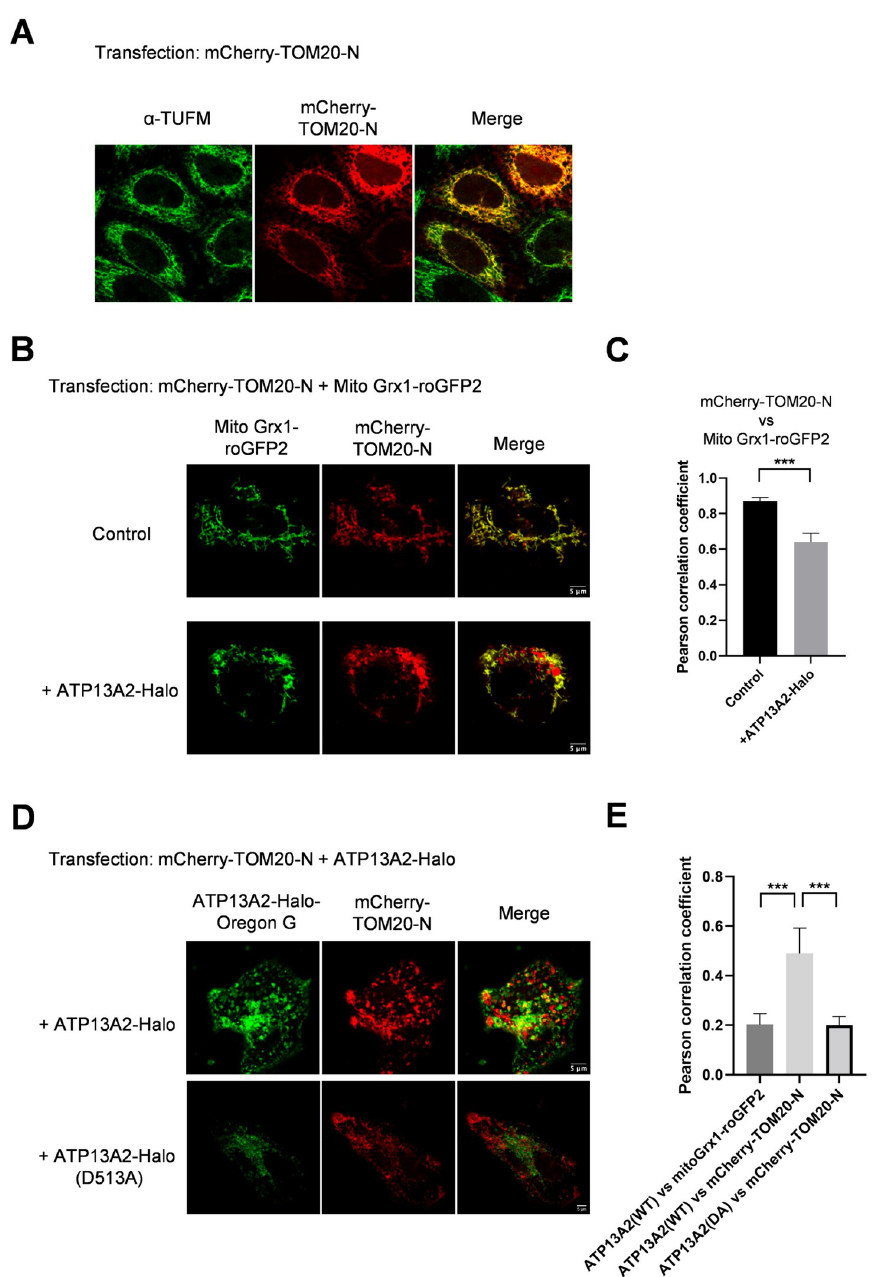
Fig 3. ATP13A2 overexpression altered the intracellular distribution of mCherry-TOM20-N (mitochondrial outermembrane, MOM). (A) MOM protein, mCherry-TOM20-N, was overexpressed in HeLa cells and mitochondrial localization was confirmed by immunostaining; TOM20 exhibited complete colocalization with the endogenous mitochondrial protein, TUFM. (B) Mitochondria was visualized by mitochondrial intermembrane space (IMS)/matrix marker, mito Grx1-roGFP2. Upon co-overexpression of ATP13A2, substantial portion of mCherry- TOM20-N appeared as particulate structures. Scatter plots are also shown in S3 Fig (C) Pearson correlation coefficients of mCherry-TOM20-N and mito Grx1-roGFP2 are shown. Data represent averages of n = 10 samples with S.E.M. (bars). Statistical analysis was performed using Student’s t test: � p < 0.05, �� p < 0.01, ��� p < 0.001. (D) mCherry- TOM20-N and ATP13A2-Halo were coexpressed and their localizations were analyzed by live-cell imaging. TOM20 showed mixed localization pattern with mitochondria-like tubular shapes and particulate structures. The latter signals substantially merge with ATP13A2-positive vesicles. Catalytically dead mutant of ATP13A2 (D513A) produced no effect on the localization pattern of mCherry-TOM20-N. Scatter plots are also shown in S4 Fig (E) Pearson correlation coefficients of indicated proteins are shown. Data represent averages of n = 10 samples with S.E.M. (bars). Statistical analysis was performed using Student’s t test: � p < 0.05, �� p < 0.01, ��� p < 0.001.